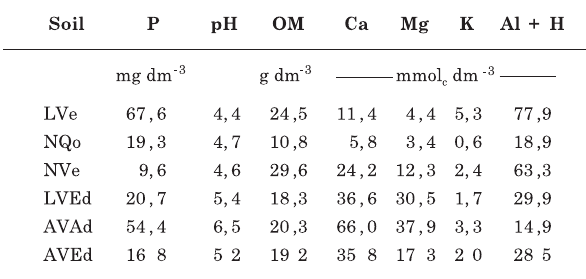
Table 2. Chemical analysis of soil